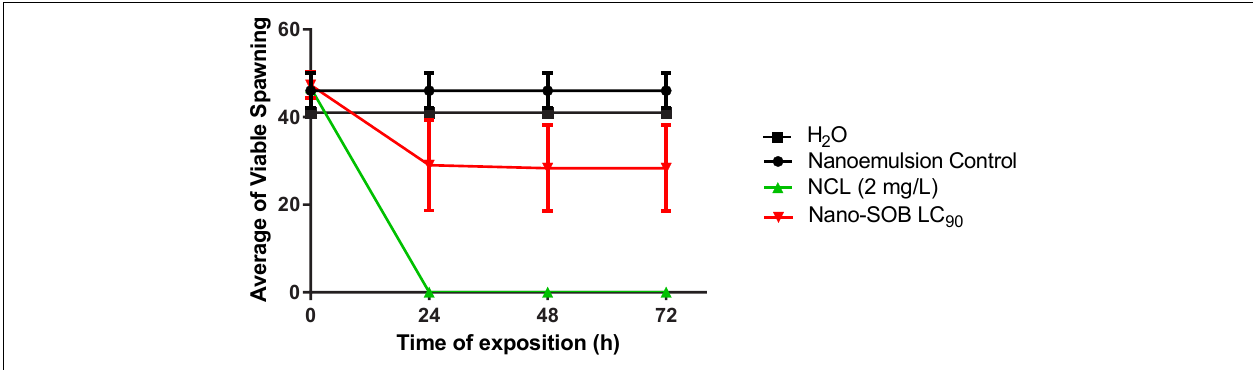
FIGURE 5 | Effect of nano-SOB on the spawning of Biomphalaria glabrata in the period from 24 to 72 h of exposure. The test was repeated three times in triplicate. A range of 40–45 spawns was used per well. These data are expressed as the mean ± SD. Using the two-way ANOVA test, the value of R 2 is determined as 0.5820, with a P value of